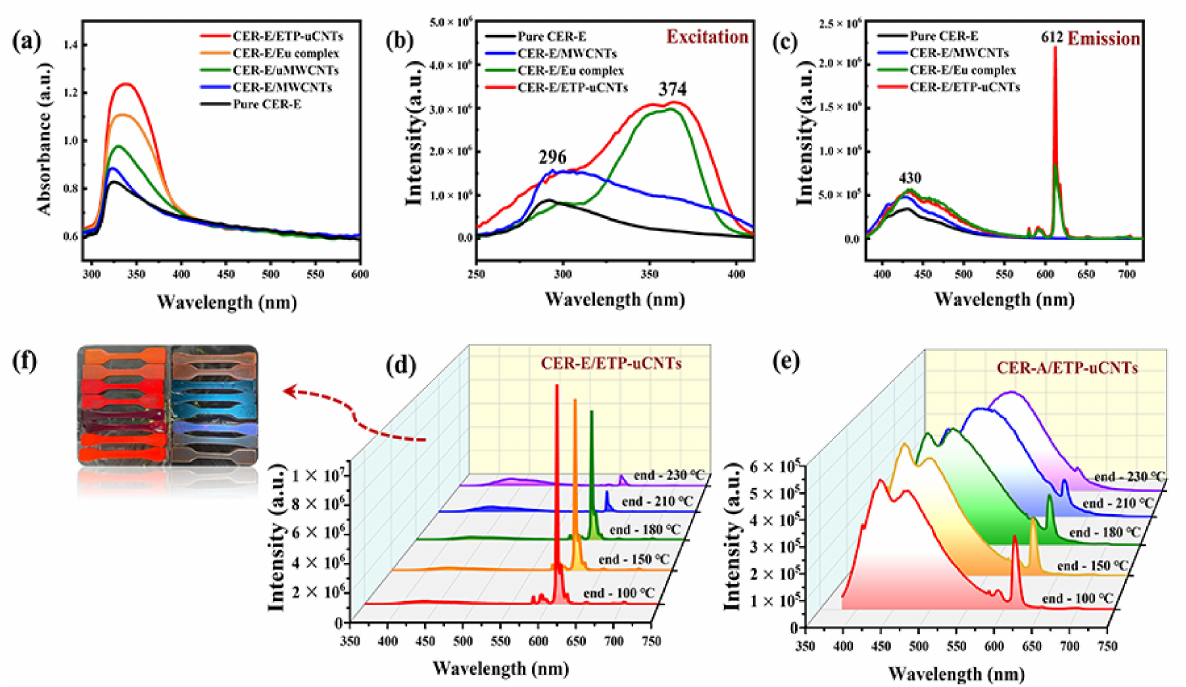
Figure 8. Craic full spectrum-UV-Vis spectra of CER-E based nanocomposites ( a ). Fluorescence spectra of the excitation ( b ) and emission ( c ) of the pure CER-E/0.8 wt.% MWCNTs, Eu complex (ETP) and ETP-uCNTs. Emission spectrum of CER-E/ETP-uCNTs ( d ) and CER-A/ETP-uCNTs ( e ). Sample camera image under UV light ( f